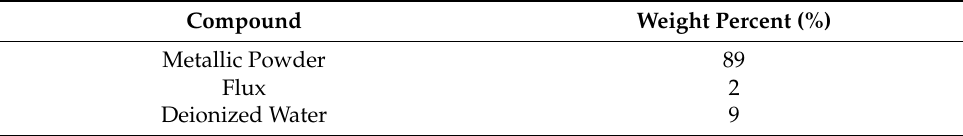
Table 2. Composition of the slurry used for tape casting. Compound